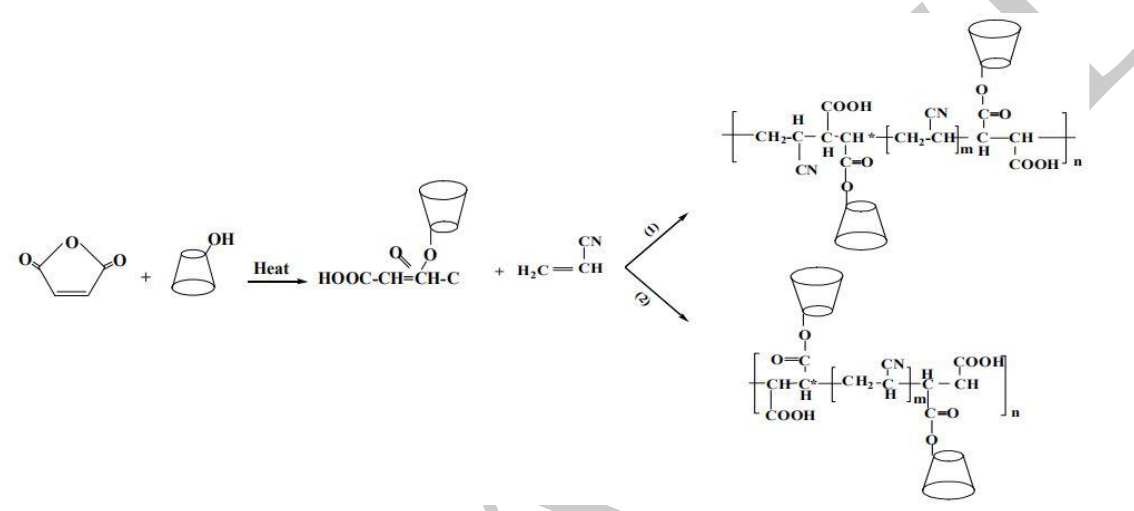
Figure 1. Scheme for the preparation of the β -CD- g -(MAH- co -AN) copolymer.